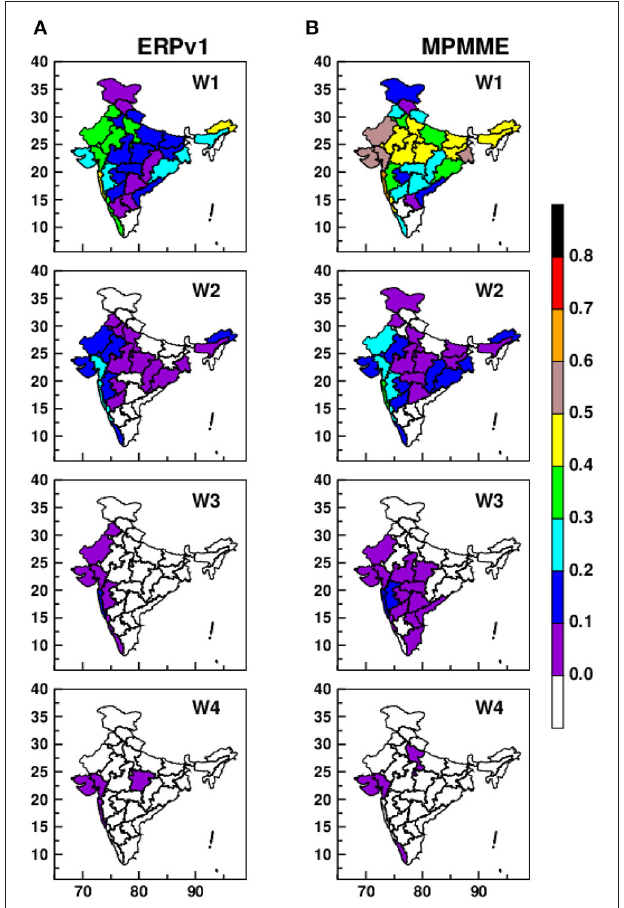
FIGURE 6 | Sub-divisional skill in terms of root mean square score for (A) extended range prediction system (ERPv1) and (B) multi-physics multi-model ensemble (MPMME) during monsoon.